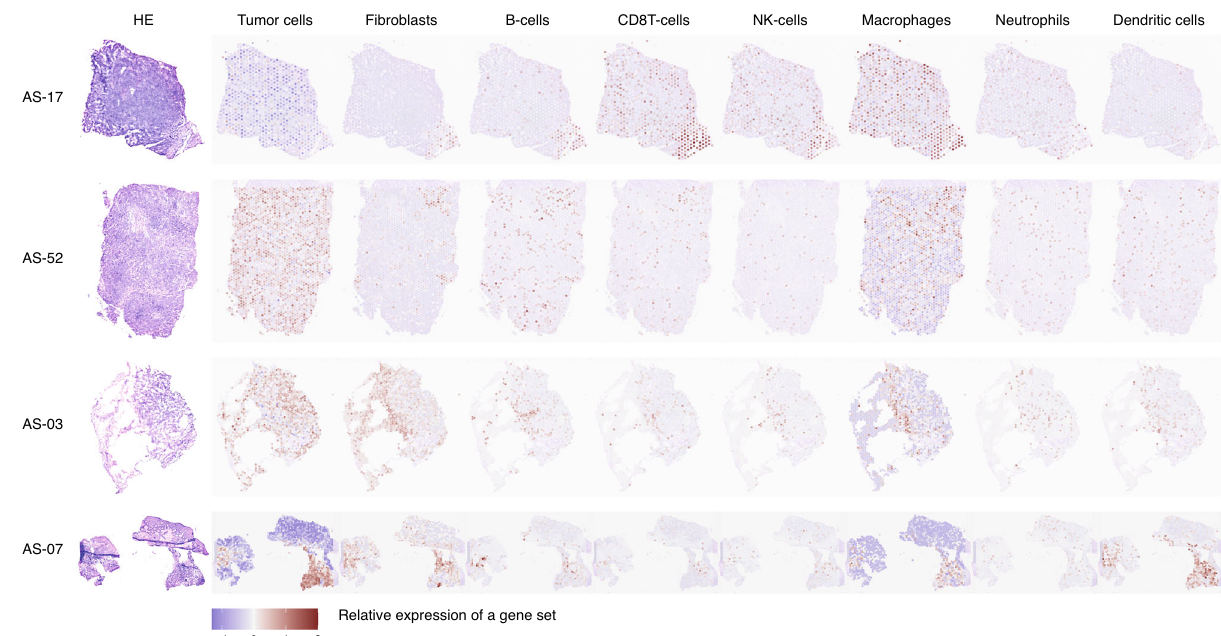
Fig. 5 Spatial transcriptomics of cell populations in the tumor microenvironment. H&E images of four head and neck angiosarcomas were shown, along with panels illustrating the estimated distribution of the tumor cells, stromal cells, as well as various immune cells in each